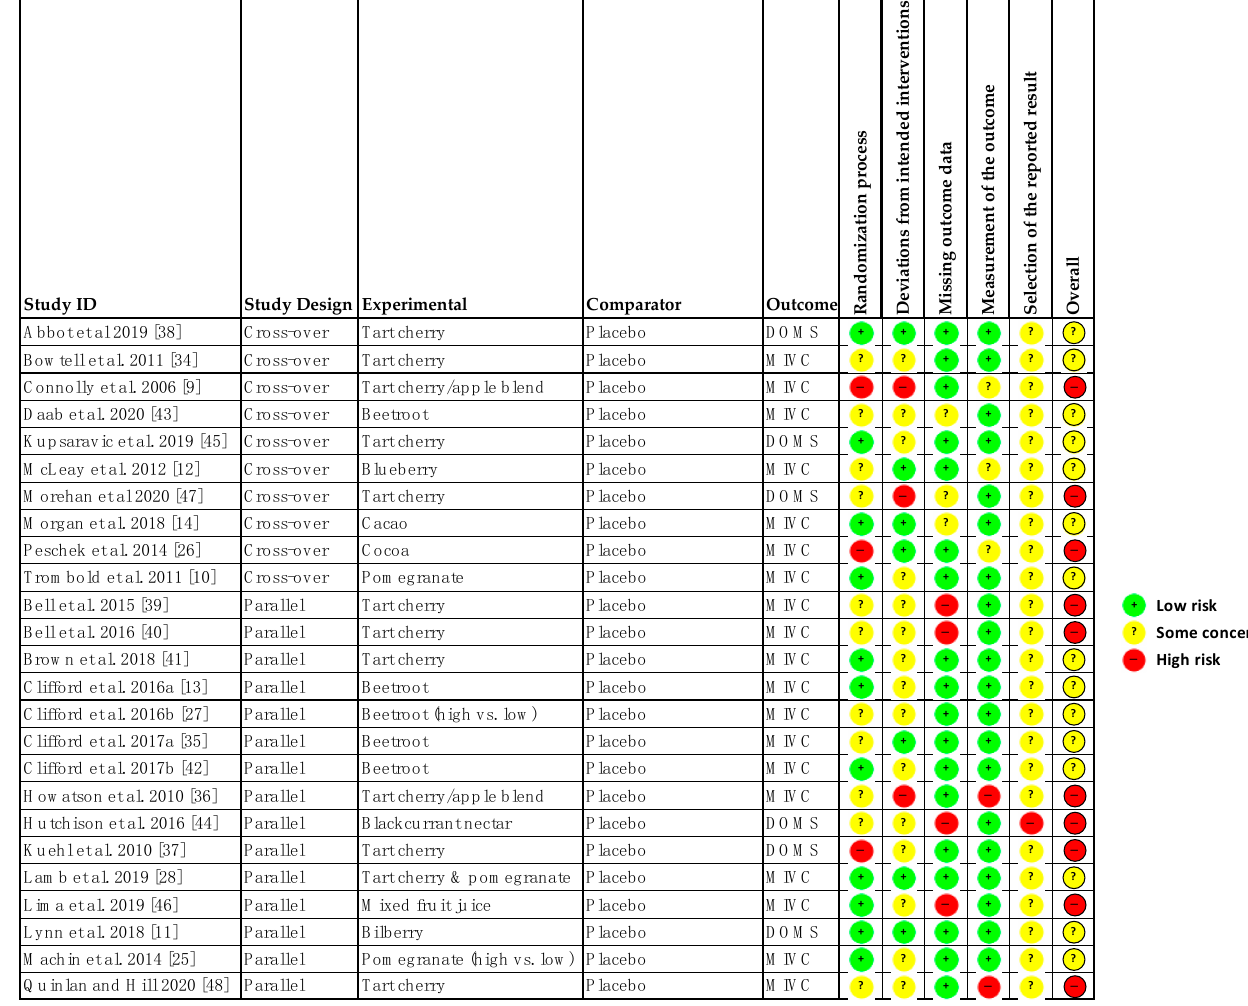
Figure 2. Risk of Bias Tool 2 [23]. MIVC: Maximal isometric voluntary contraction; DOMS: Delayed onset muscle soreness.